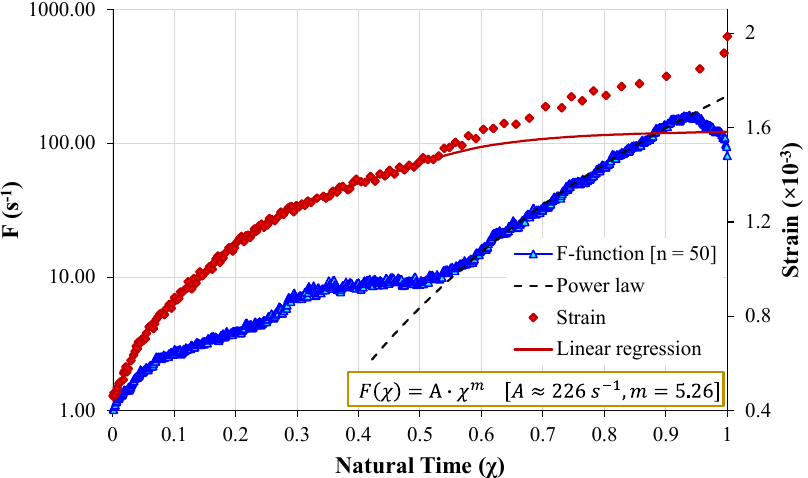
Figure 8. The evolution in the Natural Time domain of the F -function and the axial strain developed for the intact prismatic specimen under compression.